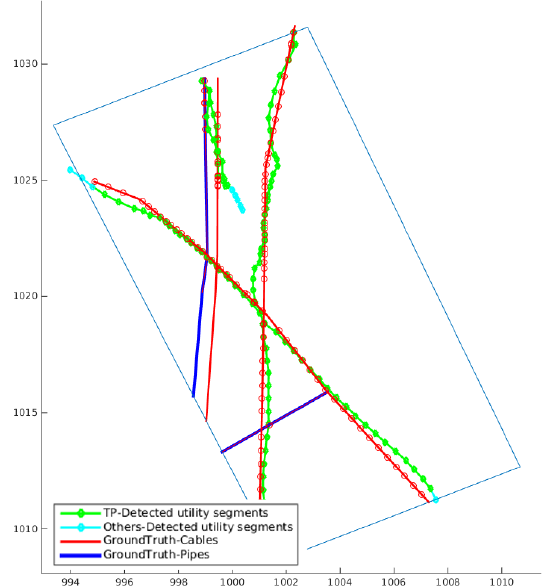
Figure 11. Experimental results of the MCS algorithm with three groups of GPR data sharing common scan lines in the Glen Eyre test site. The ground truth in the surveyed area is shown by blue and red solid lines; correctly located utility segments (TP: true positive) are marked by green dotted lines with the red circles on the ground truth lines the corresponding closest points of the ground truth; and false positive/unknown utility segments are marked by cyan dotted lines (best viewed in